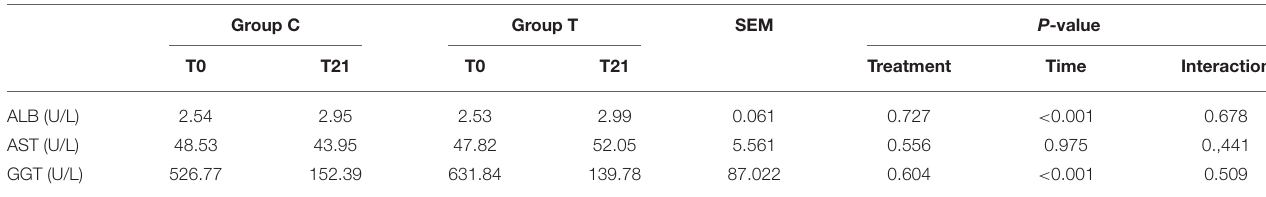
TABLE 3 | Results of albumin (ALB), aspartate aminotransferase (AST) and gamma-glutamyl transferase (GGT) concentration expressed as LSmean for group C ( n = 20 calves) and group T ( n = 20 calves) at 0 and 21 days of life. Group C Group T SEM P -value Treatment Time